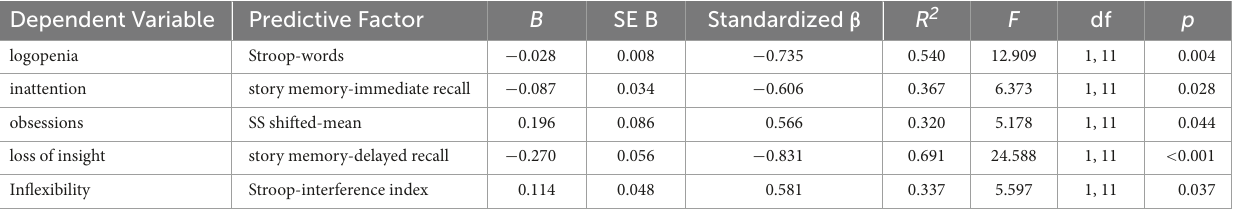
TABLE 3 Summary of the second set of stepwise regression analyses regarding the neuropsychological tests with the greatest contribution to each behavioral symptom, as assessed by the FBI ratings.